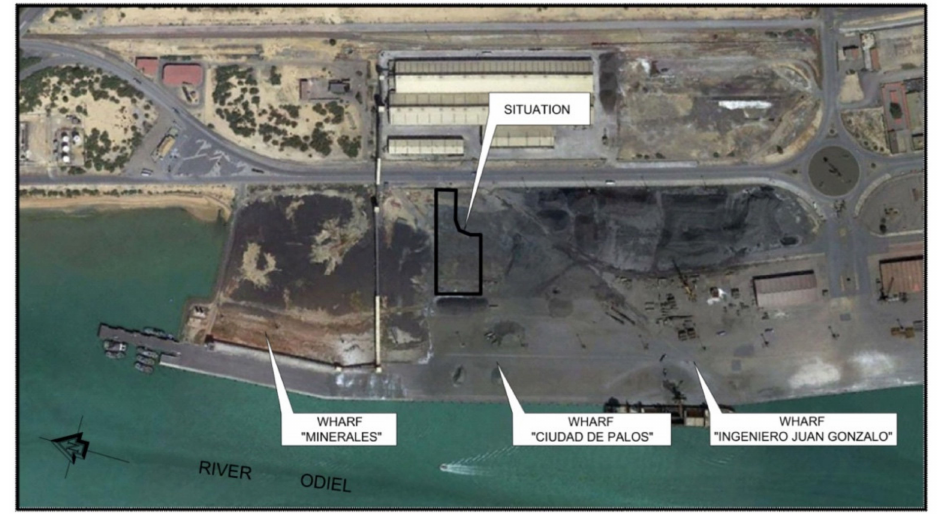
Figure 1. General view of the test